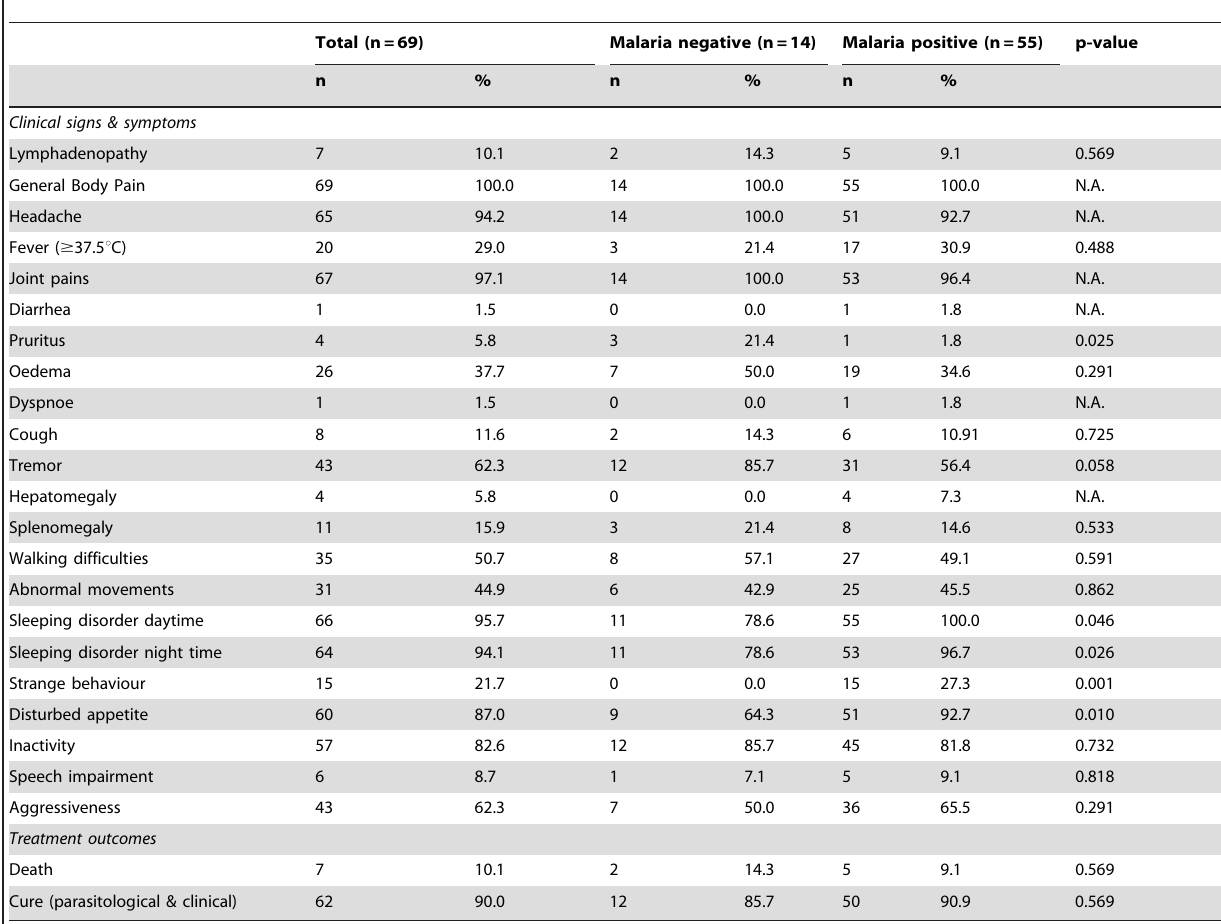
Table 4. Clinical signs and symptoms and treatment outcomes in malaria co-infected patients from